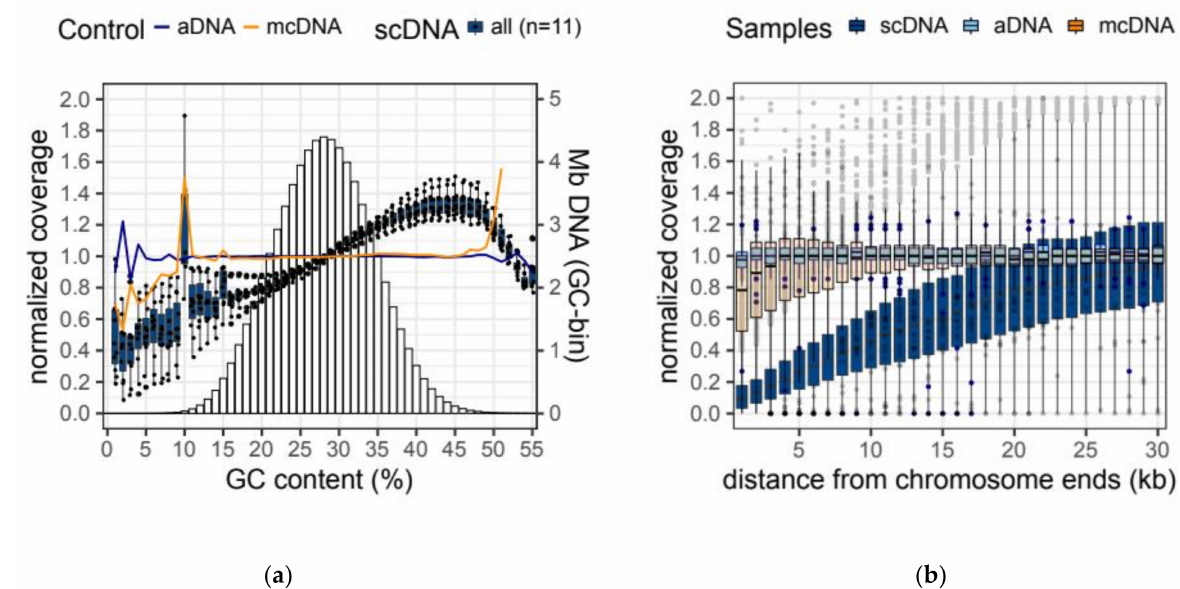
Figure 1. Amplification biases of MDA-based single-cell DNA seq. ( a ) Positive GC Bias . Change in normalized base coverage with GC content (%). Normalized coverage = n ◦ reads/base/mean coverage. Bar chart in the background shows the amount of DNA for each GC bin (Megabases, Mb, secondary axis); ( b ) Terminal Bias . Change in normalized base coverage with distance from chromosome termini (kilobases, kb). Data are from 11 single-cell sequencing samples (scDNA), their parental mass culture sample (mcDNA), and one artificially generated sample (aDNA). MDA, multiple displacement amplification. scDNA, single-cell DNA sequencing. mcDNA, mass culture DNA sequencing. aDNA, artificial DNA sequencing.